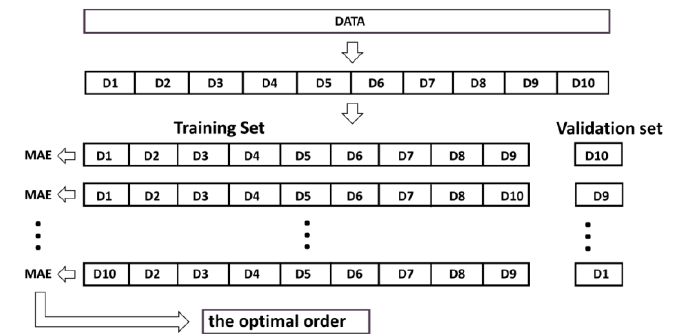
Figure 4. The process of cross-checking.